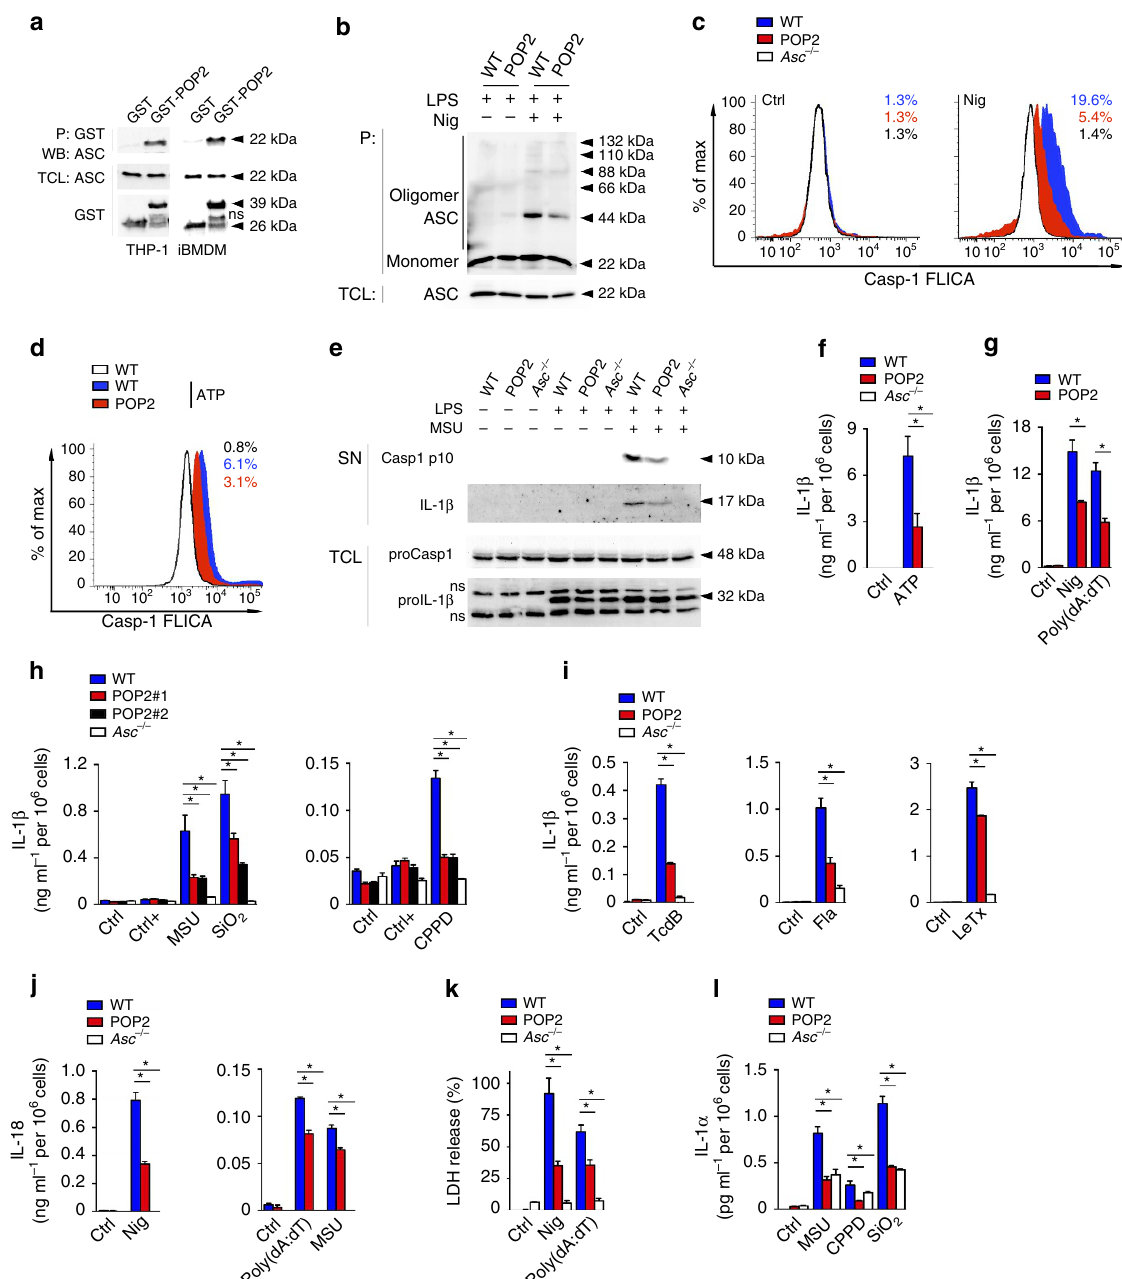
Figure 2 | POP2 inhibits inflammasome assembly and activation in mouse macrophages. ( a ) Interaction of GST-POP2 with endogenous ASC from LPS-primed THP-1 cells and iBMDM TCLs using GSTas negative control and showing 10% TCL as input. ( b ) Immunoblot analysis of ASC polymerization (oligomer) in untreated or LPS/nigericin (Nig)-treated WT BMDM and POP2 BMDM after non-reversible crosslinking of pellets (P) and in TCL. ( c , d ) Flow cytometric quantification of active caspase-1 in LPS-primed WT, POP2 and Asc (cid:2) / (cid:2) BMDM that were treated with control (Ctrl) or ( c ) nigericin or ( d ) ATP, % FLICA þ live, single cells is listed. ( e ) Immunoblot analysis of active caspase-1 p10 and IL-1 b release into culture SN of control, LPS-primed and LPS-primed and MSU-treated WT, POP2 and Asc (cid:2) / (cid:2) BMDM. Pro-caspase-1 and pro-IL-1 b expression in TCL confirms equal loading. ns indicates a cross- reactive nonspecific protein. ( f – i ) Analysis of culture SN for IL-1 b release by ELISA in control (Ctrl), LPS-primed (Ctrl þ ), or LPS-primed and ( f ) ATP- treated, ( g ) nigericin-treated or poly(dA:dT)-transfected and ( h ) MSU, SiO 2 or CPPD or ( i ) TcdB-treated or flagellin (Fla) and Bacillus anthracis lethal toxin- transfected WT, POP2 and Asc (cid:2) / (cid:2) BMDM. ( h ) POP2#1 and POP2#2 BMDM represent two independent POP2 TG lines. ( j – l ) Analysis of culture SN for release of ( j ) IL-18, ( k ) LDH and ( l ) IL-1 a in response to the treatment of WT, POP2 and Asc (cid:2) / (cid:2) BMDM as above. Between three and five independent repeats were performed for each experiment. Significance was calculated by a standard two-tailed unpaired t -test and error bars represent s.e.m., * P o